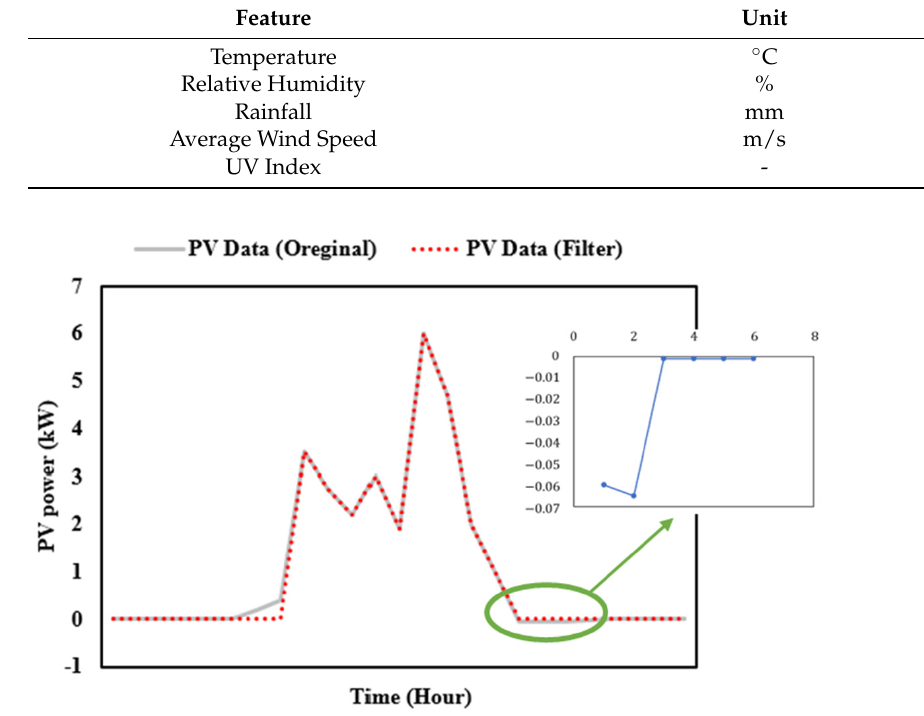
Figure 5. The filtration result of solar photovoltaic power data. The green circle shows the change from the blue line to the red line. Table 4. Final features selected from the